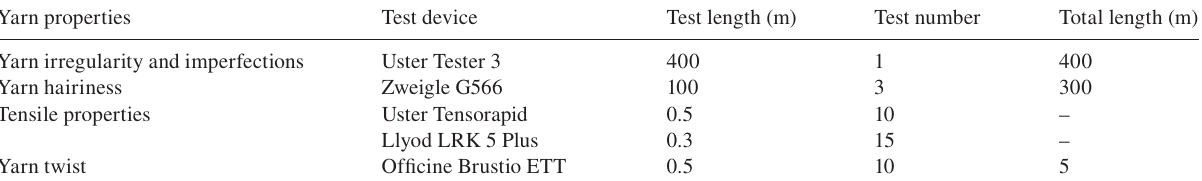
Table 3 Test particulars for each yarn sample.